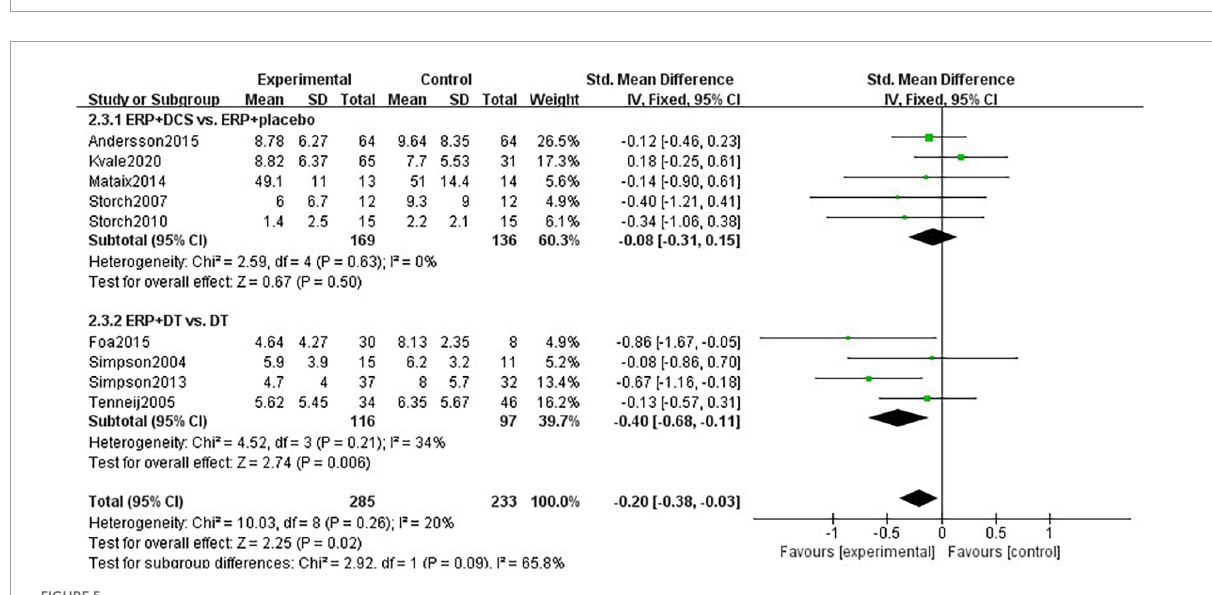
FIGURE5 Subgroup analysis of the effect of combination therapy on depression intervention in patients with